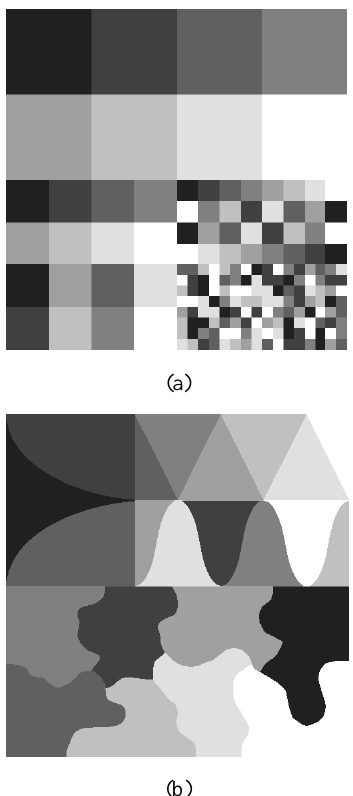
Figure 18 Two images from USC-SIPI-Textures data set (Weber